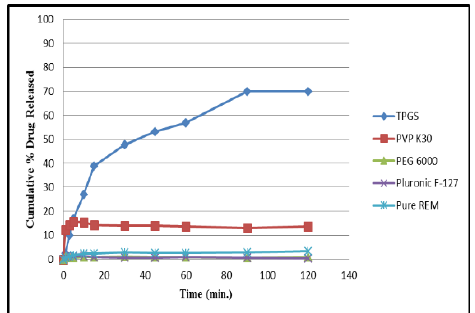
Figure 5. Effect of polymer type of rem- solid dispersion prepared by solvent evaporation method with drug: polymer ratio 1:12 on the release profile of rem in 0.1 N HCl dissolution medium at 37°c (results are expressed as mean, n=3).